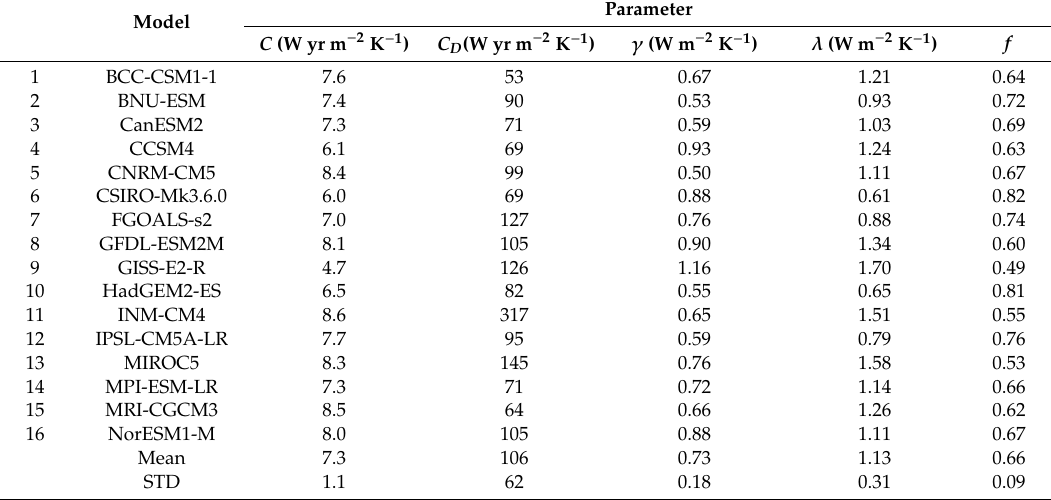
Table 1. The thermal inertia parameters C and C D , deep-ocean heat uptake γ , climate feedback parameter λ , and climate feedback factor f estimates of the Coupled Model Intercomparison Project phase 5 (CMIP5) models used in this study, and their multimodel mean and standard deviation given for the 16-model ensemble (all parameter values, with the exception of the climate feedback factor, are taken from